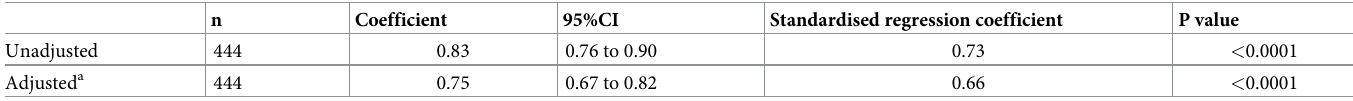
Table 6. Linear regression analysis of association between PhQ9 score at 12 weeks and rCIS-R score at 12